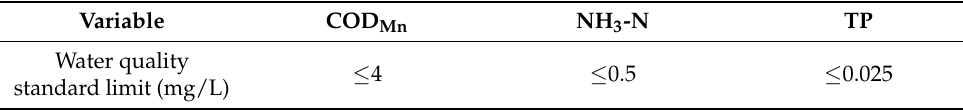
Table 3. Limit value of water quality standard for Class